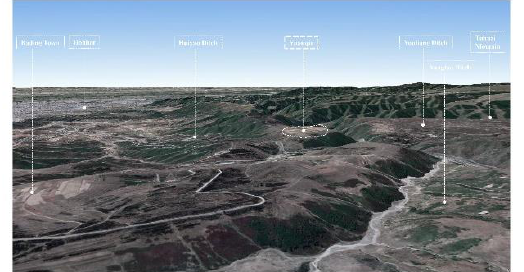
Figure 3. An analysis of the line of sight to the